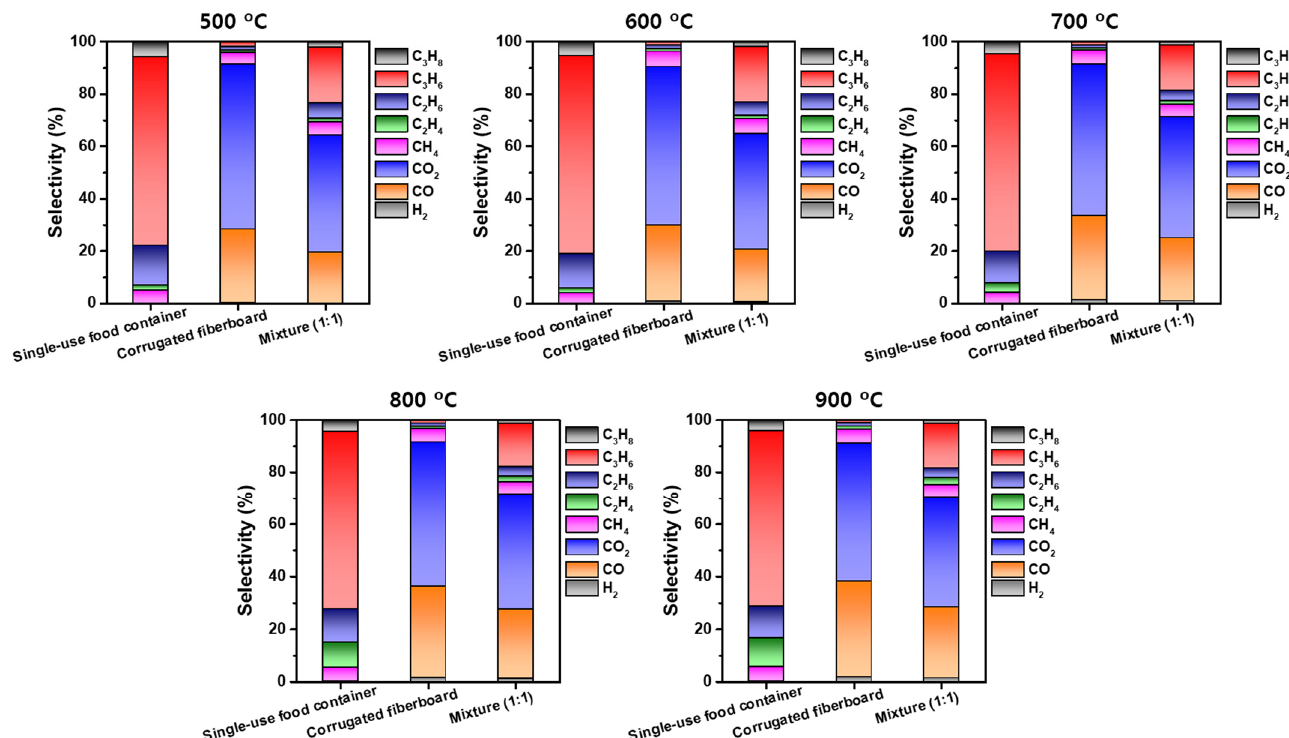
Figure 3. Selectivities toward non-condensable gases contained in the pyrolytic gas produced via the pyrolysis of single-use food containers, corrugated fiberboard, and a mixture of single-use food containers and corrugated fiberboard (1:1; mass basis) at different pyrolysis temperatures.